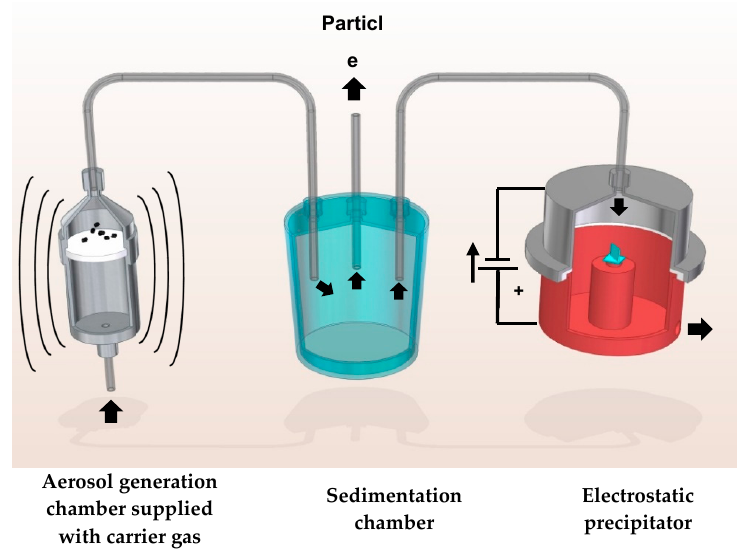
Figure 2. Schematic of the electrostatic nanofiber aerosol precipitation setup.